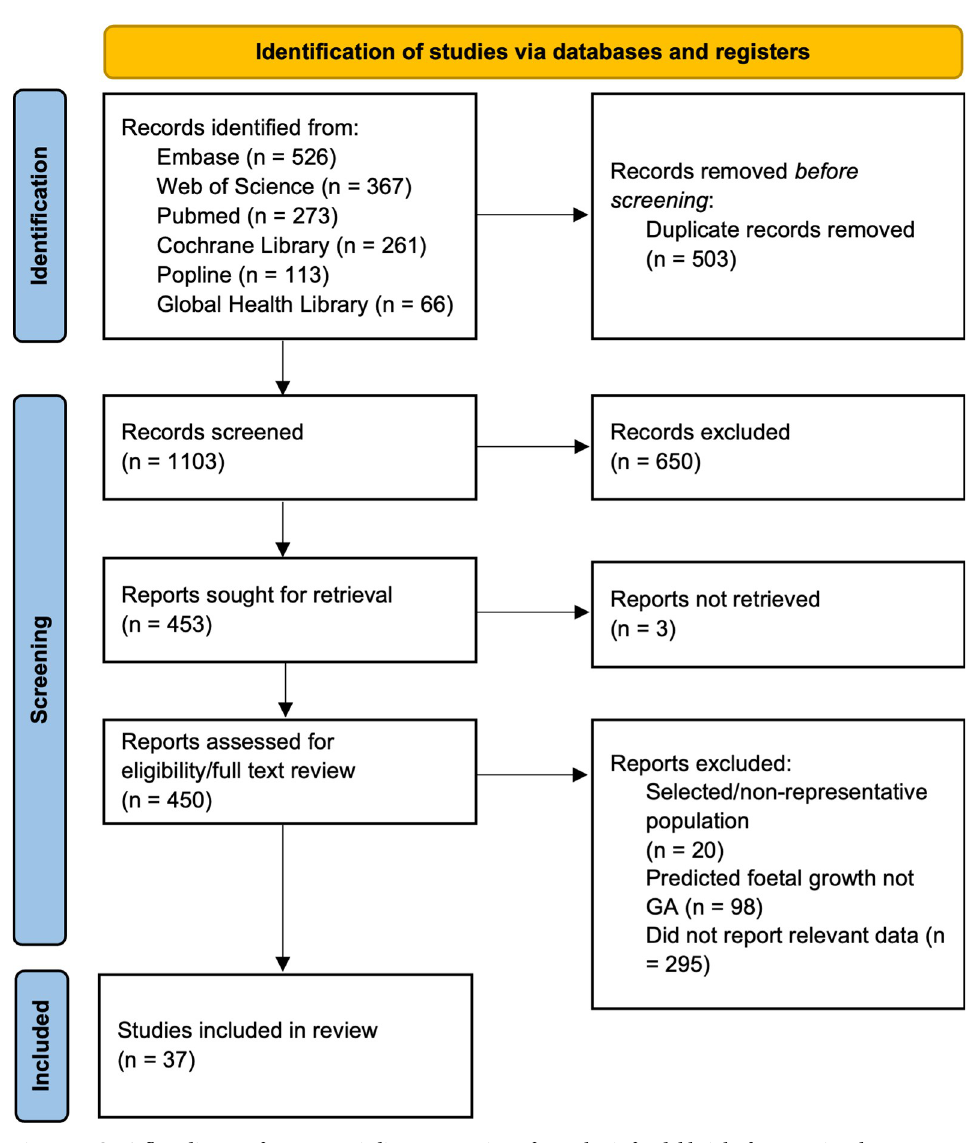
Fig 1. PRISMA flow diagram for systematic literature review of symphysis fundal height for gestational age estimation.